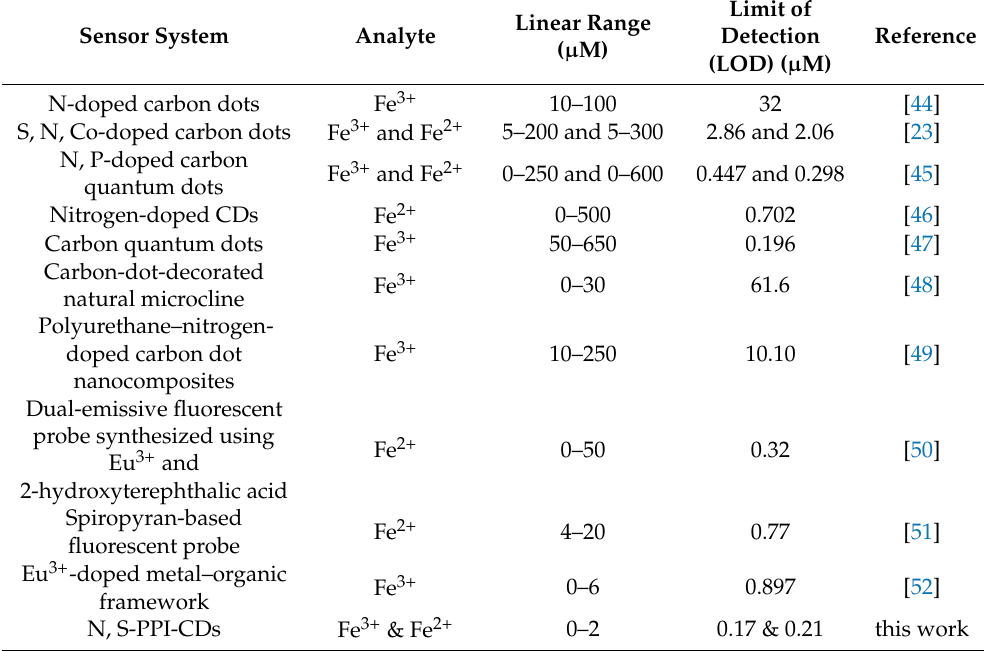
Table 1. Fluorescence sensors in the literature for Fe 3+ /Fe 2+